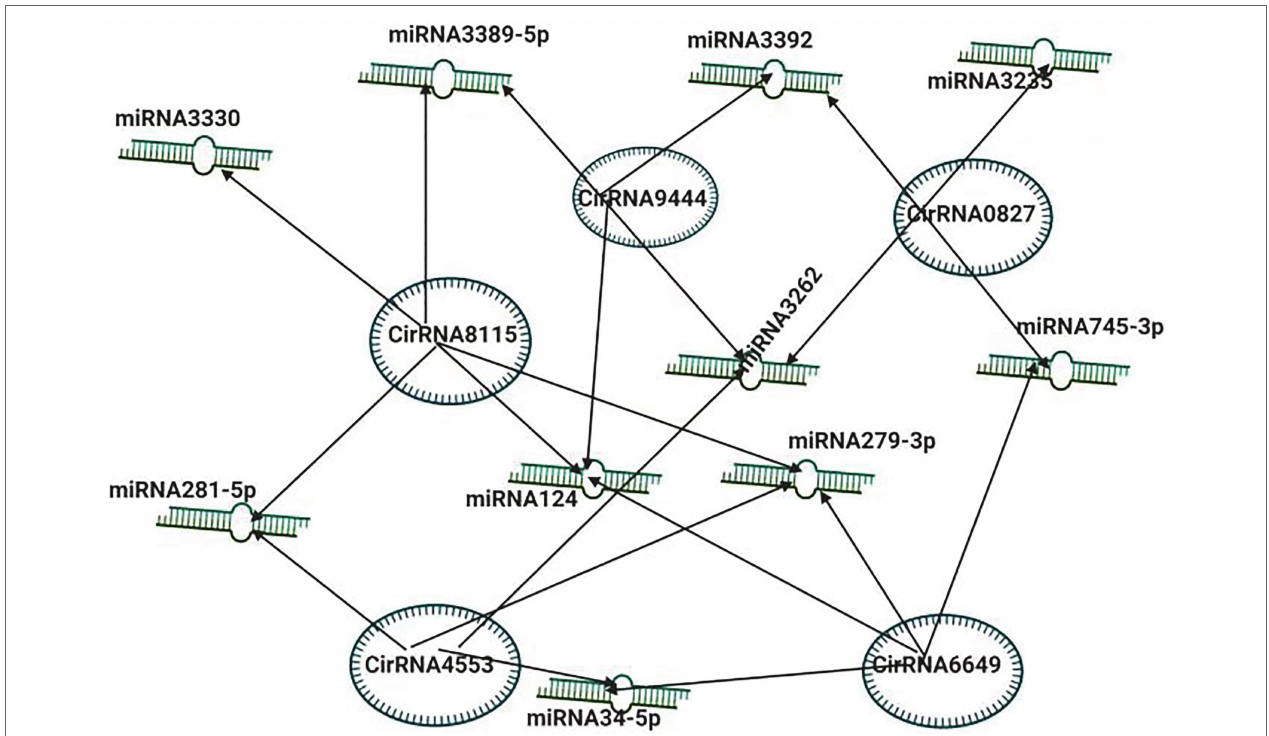
FIGURE 3 | Inter-Play between miRNA and non-coding circRNAs. The circRNA-miRNA co-expression network in silkworm. circRNAs that sponged more than four miRNAs and modulating the vital processes are